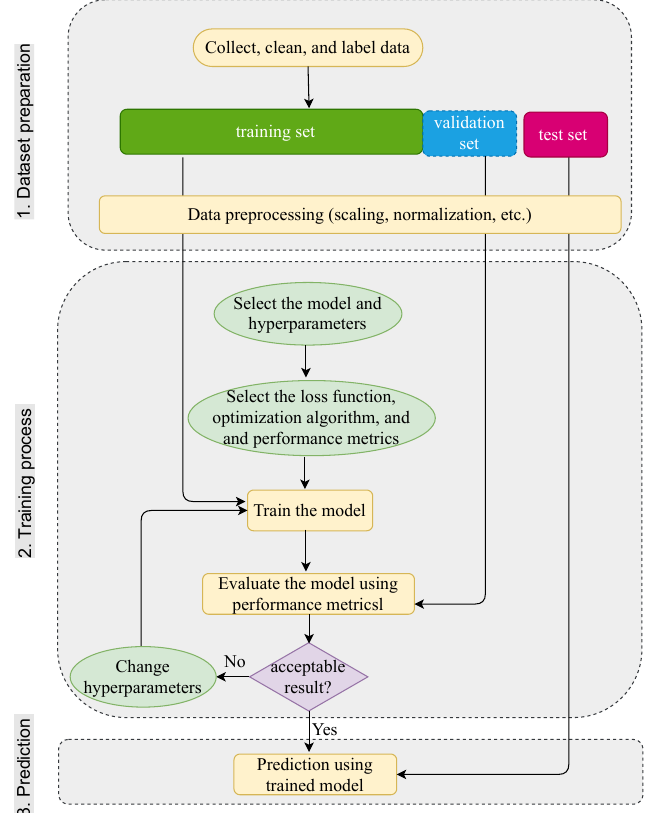
Figure 11. Flowchart for DL algorithm tasks. The test data is obtained by splitting the original dataset, which is not used for training and validation. The training data is passed to the model to perform automatic feature extraction and validation to evaluate the model during training and tune the hyperparameters.